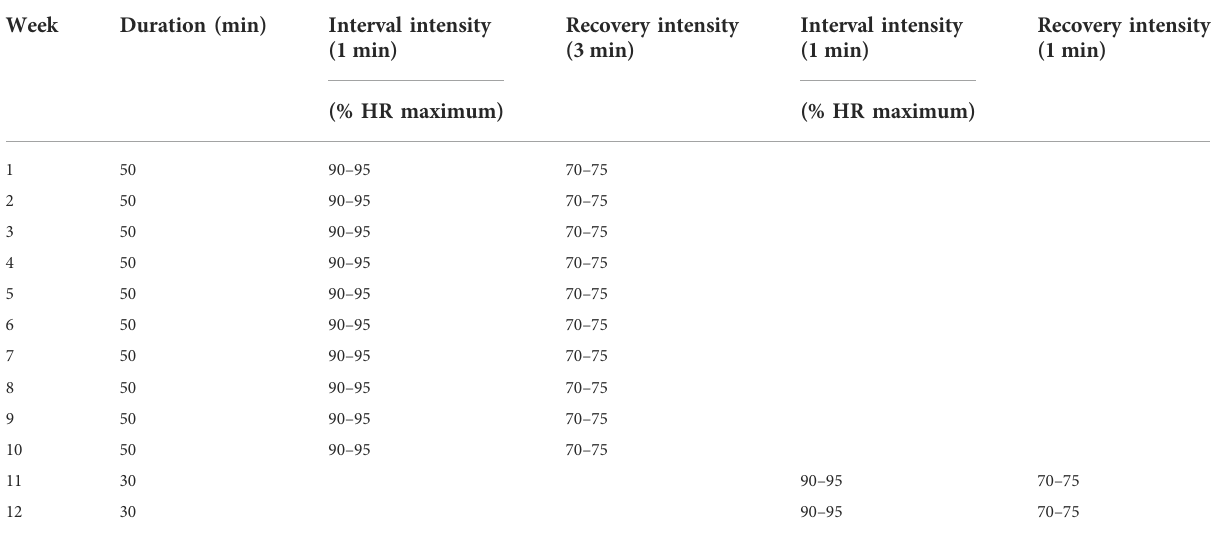
TABLE 1 Protocol of HIIT intervention during 12